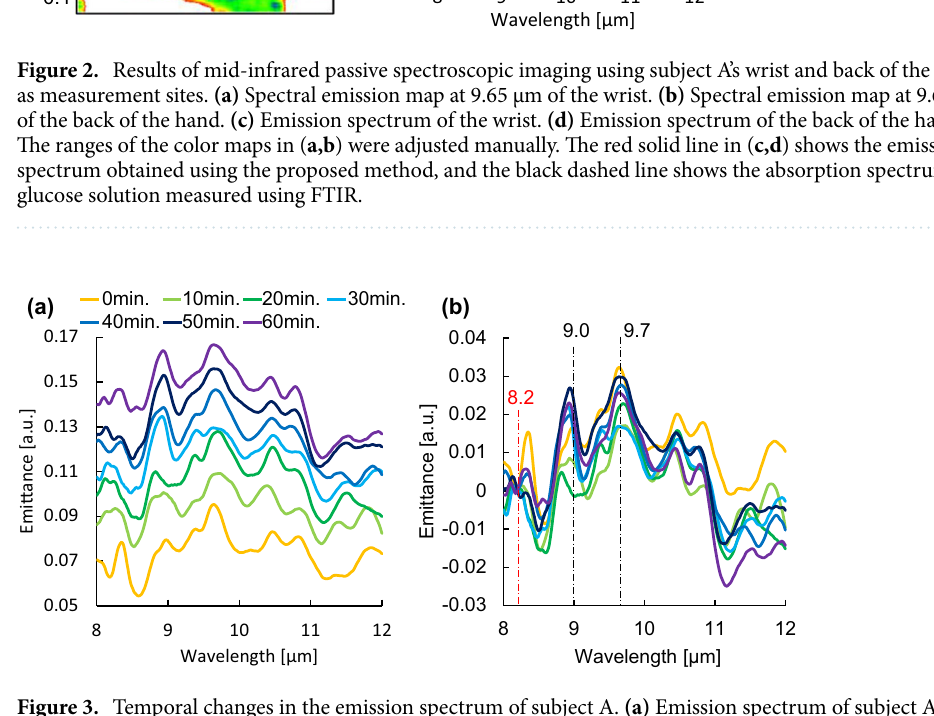
Figure 3. Temporal changes in the emission spectrum of subject A. (a) Emission spectrum of subject A taken every 10 min. (b) Emission spectra of subject A normalized to the intensity of a glucose-independent peak (8.2